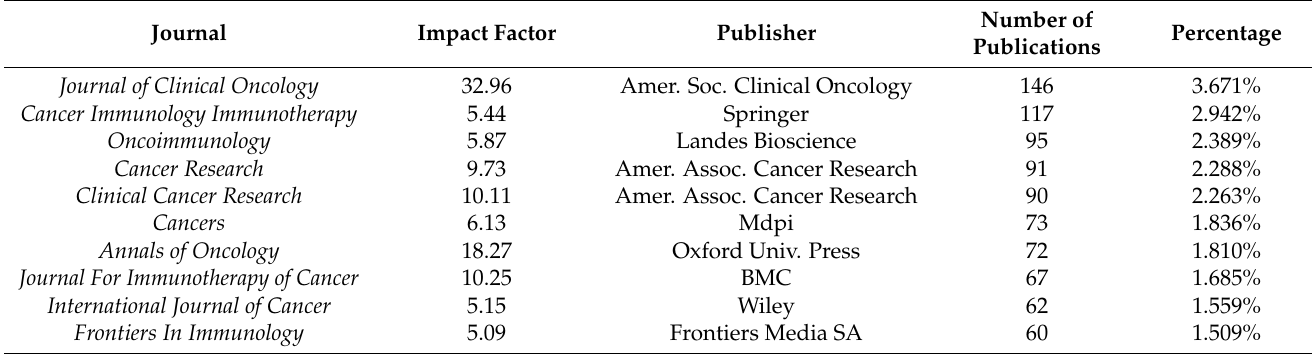
Table 2. Top 10 journals regarding the number of papers published related to immunotherapy in colorectal cancer according to the Web of Science